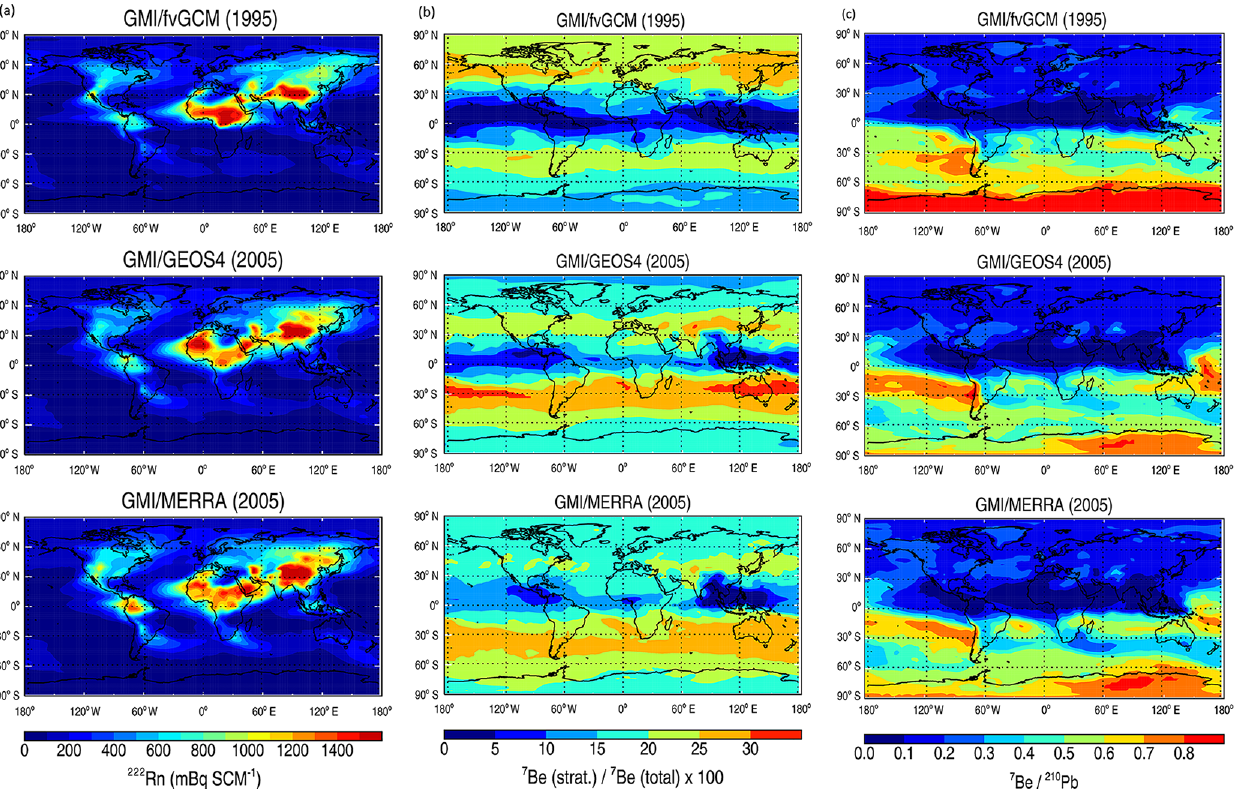
Figure 9. Mean 222 Rn concentrations (mBq SCM − 1 ) (a) , stratospheric fraction (%) of tropospheric 7 Be concentrations (b) , and ratios of 7 Be to 210 Pb volume mixing ratios (c) at 618hPa in the GMI model driven by the fvGCM (1995), GEOS-4 (2005), and MERRA (2005) meteorological data sets for the period of